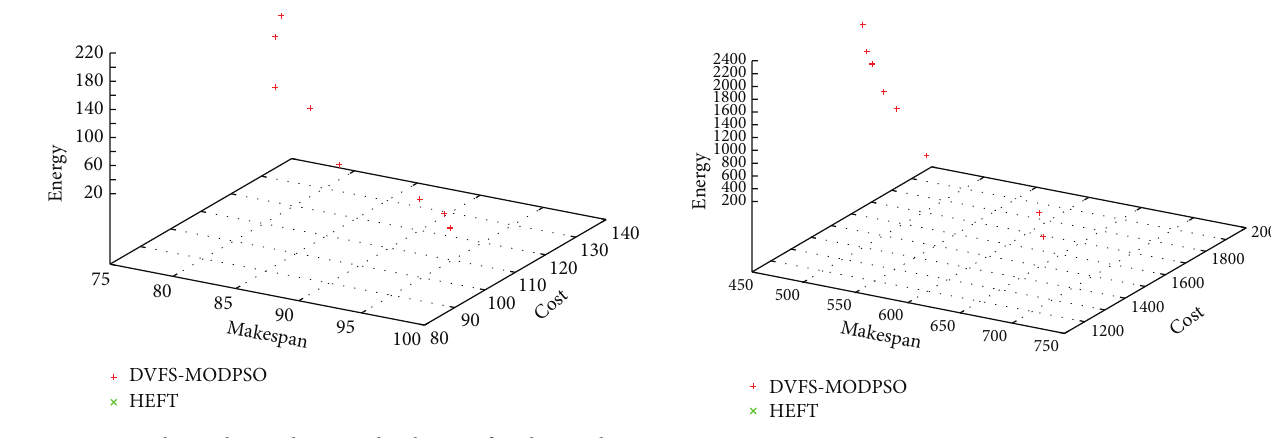
Figure 5: Obtained non-dominated solutions for the parallel work- flow.